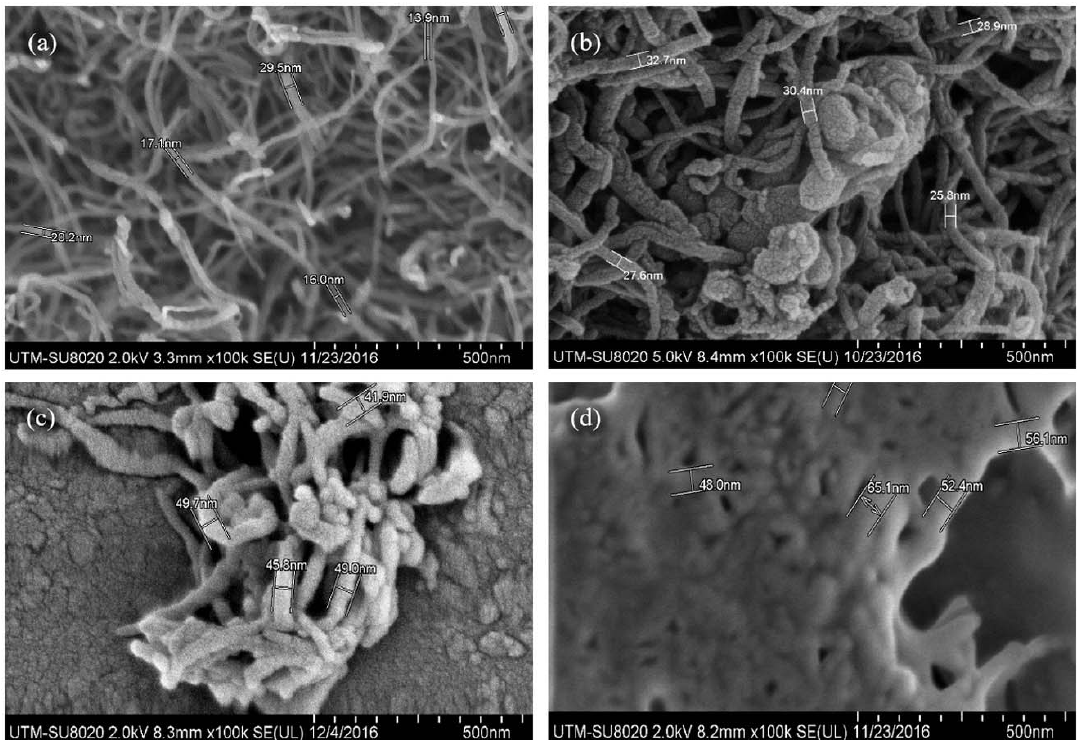
Figure 4. Field emission scanning electron microscopy photomicrographs of ( a ) F ‐ MWCNTs as well as ( b ) CRL ‐ MWCNTs, ( c ) CRL ‐ MWCNTs/GA, and ( d ) CRL ‐ MWCNTs/GA/SAF solutions on a